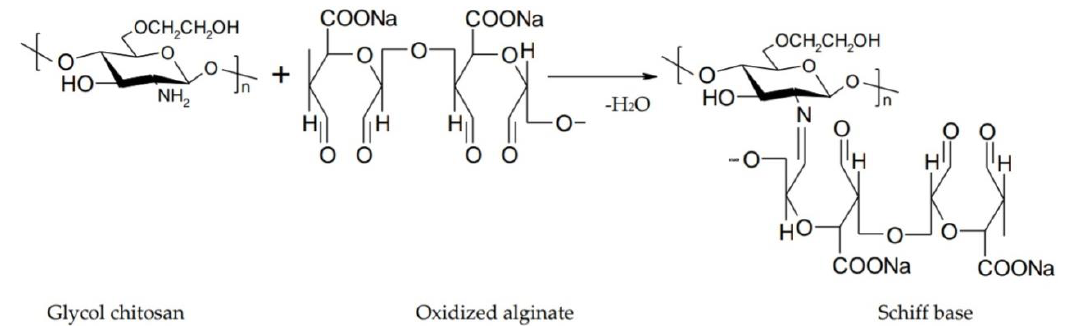
Figure 9. Interaction between glycol chitosan and oxidized alginate results in a Schiff base. Gellan gum is a natural anionic polysaccharide obtained from Pseudomonas elodea . It consists of α - L -rhamnose, β - D -glucuronic acid and D -glucose units. At room temperature, the polymer forms